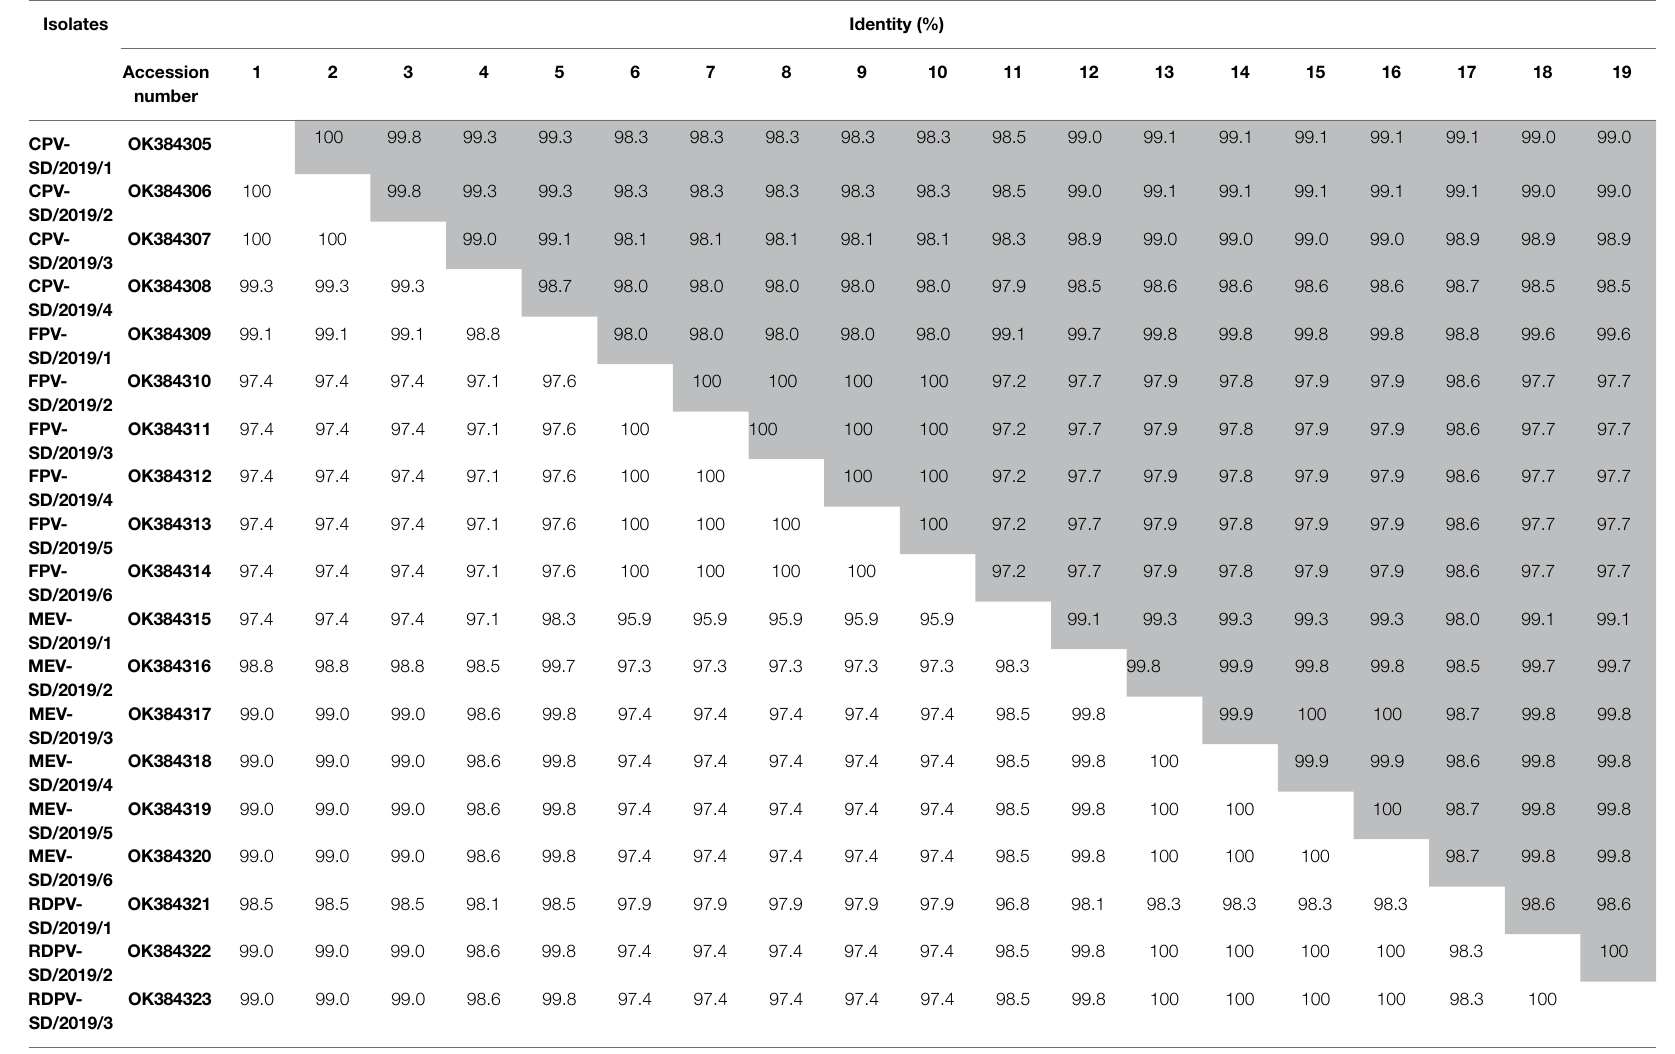
TABLE 2 | Nucleotide and amino acid homology of the isolates.